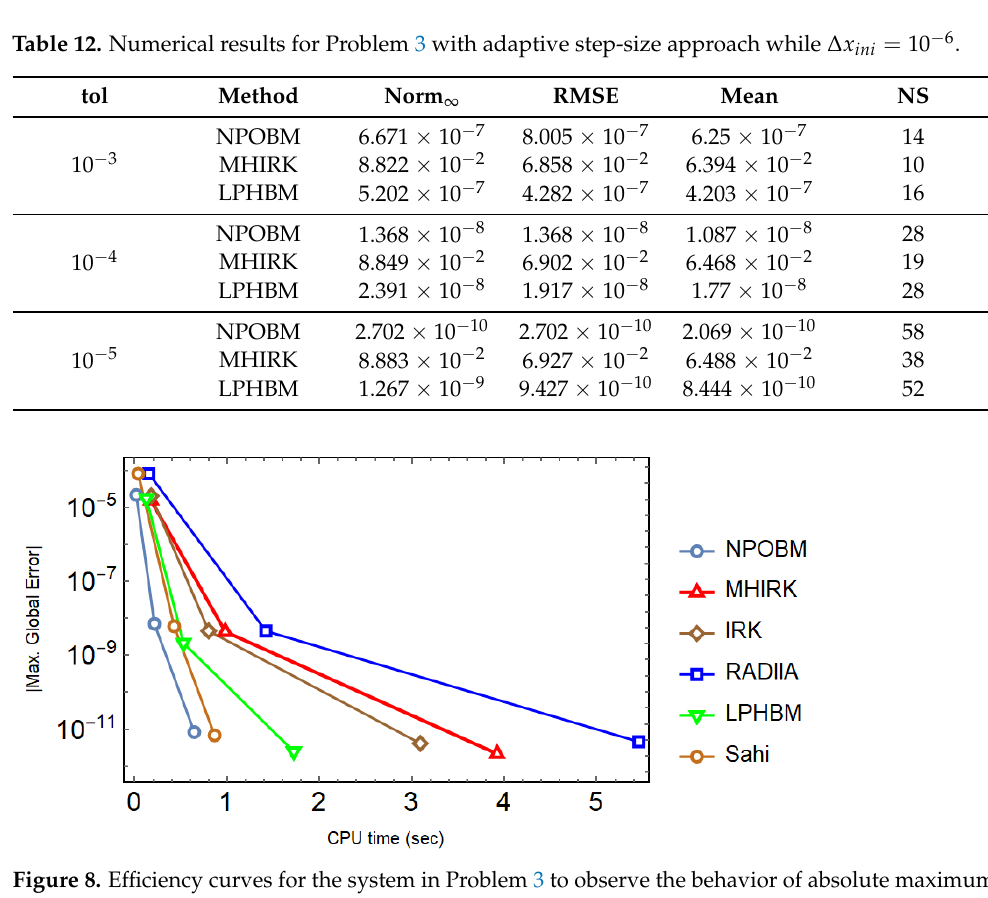
Figure 8. Efficiency curves for the system in Problem 3 to observe the behavior of absolute maximum global errors versus the CPU time (sec) with a logarithmic scale on y